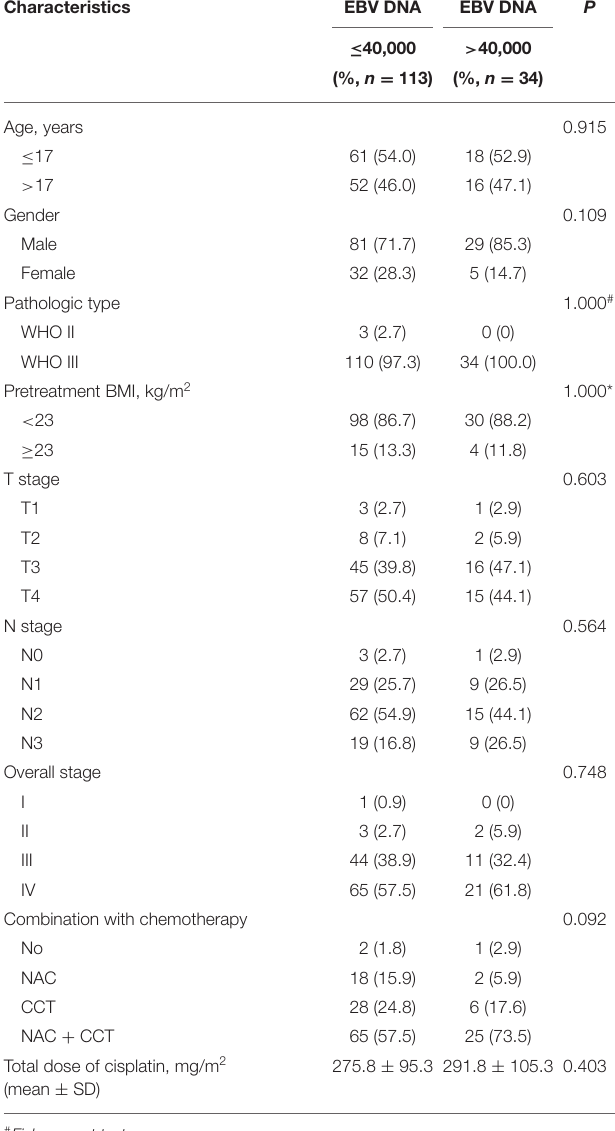
TABLE 3 | Baseline characteristics of the patients with children and adolescent NPC stratified by low vs. high pretreatment EBV DNA. Characteristics